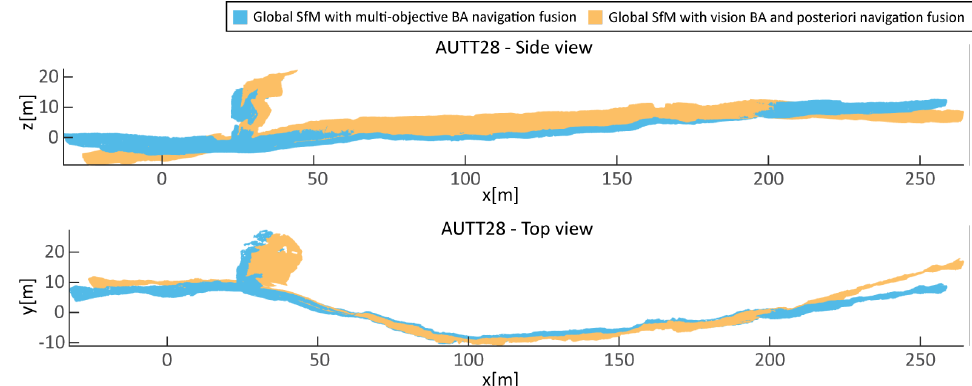
Figure 26. Comparison of navigation fusion strategies used in the reconstruction of 3D